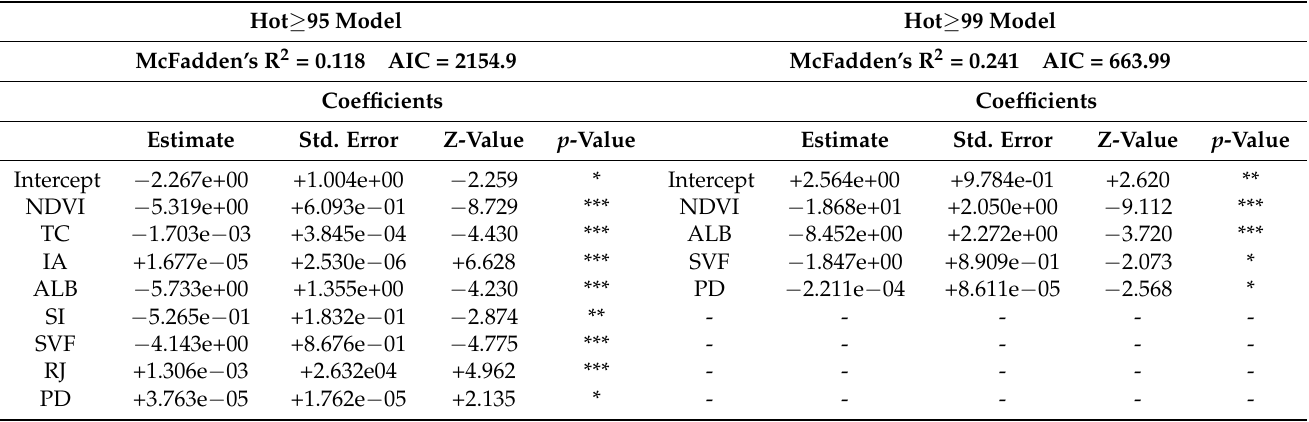
Table 8. Summaries of selected hot-spot logistic Generalized Linear Models.